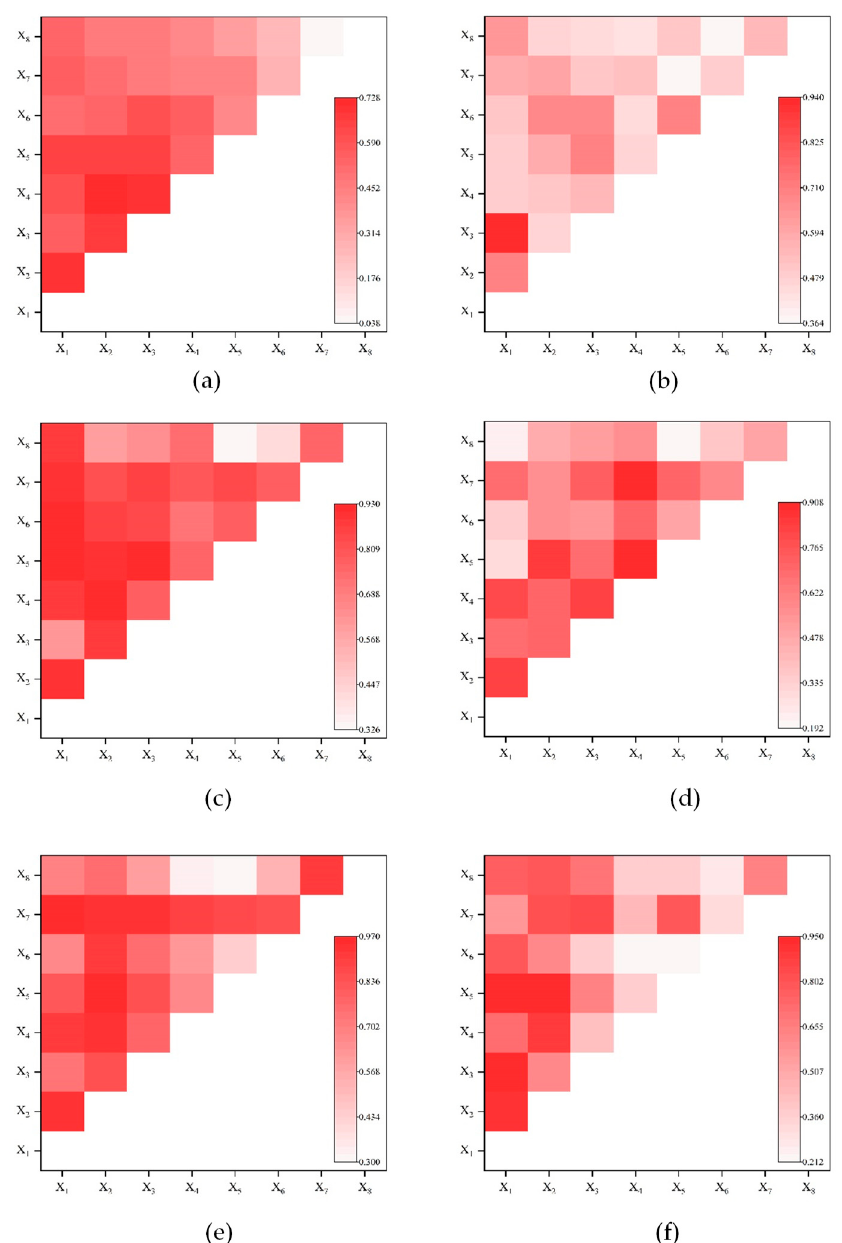
Figure 3. Interaction detection results: ( a ) Beijingnan; ( b ) Tianjinxi; ( c ) Nanjingnan; ( d ) Jinanxi; ( e ) Kunshannan; ( f ) Xuzhoudong.